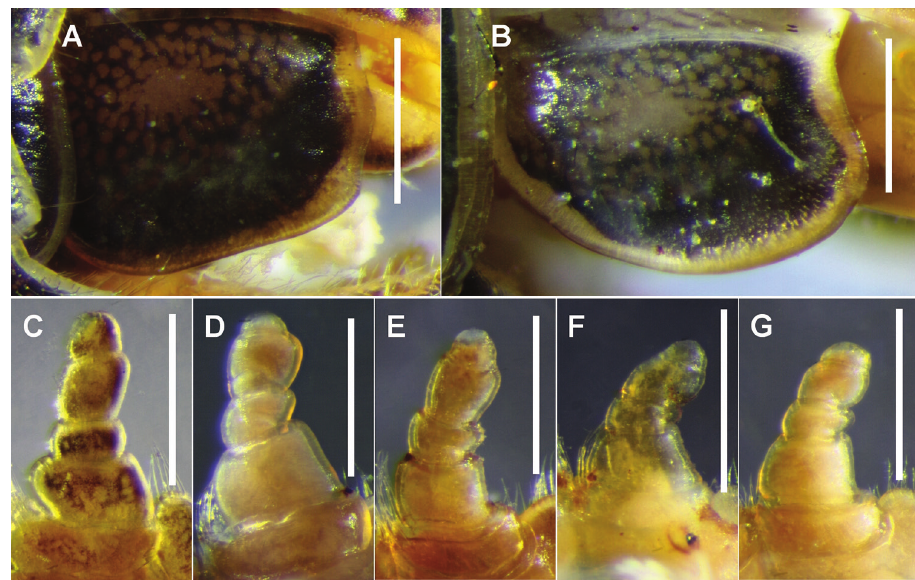
Figure 4. A, B Lateral view of right cardo of A A. danpicola sp. n., holotype, QVM 23:54377 and B Amastigogonus fossuliger Verhoeff, 1944, ex QVM 23:54468 C–G Posterior view of left leg 1 of C Amas- tigogonus danpicola sp. n., ex QVM 23:54390 D A. hellyeri sp. n., ex QVM 23:54470 E A. michaelsae sp. n., QVM 23:54387 F A. tasmanianus (Chamberlin, 1920), ex QVM 23:54344 and G A. verreauxii (Gervais, 1847), TMAG J5915. All scale bars = 0.5